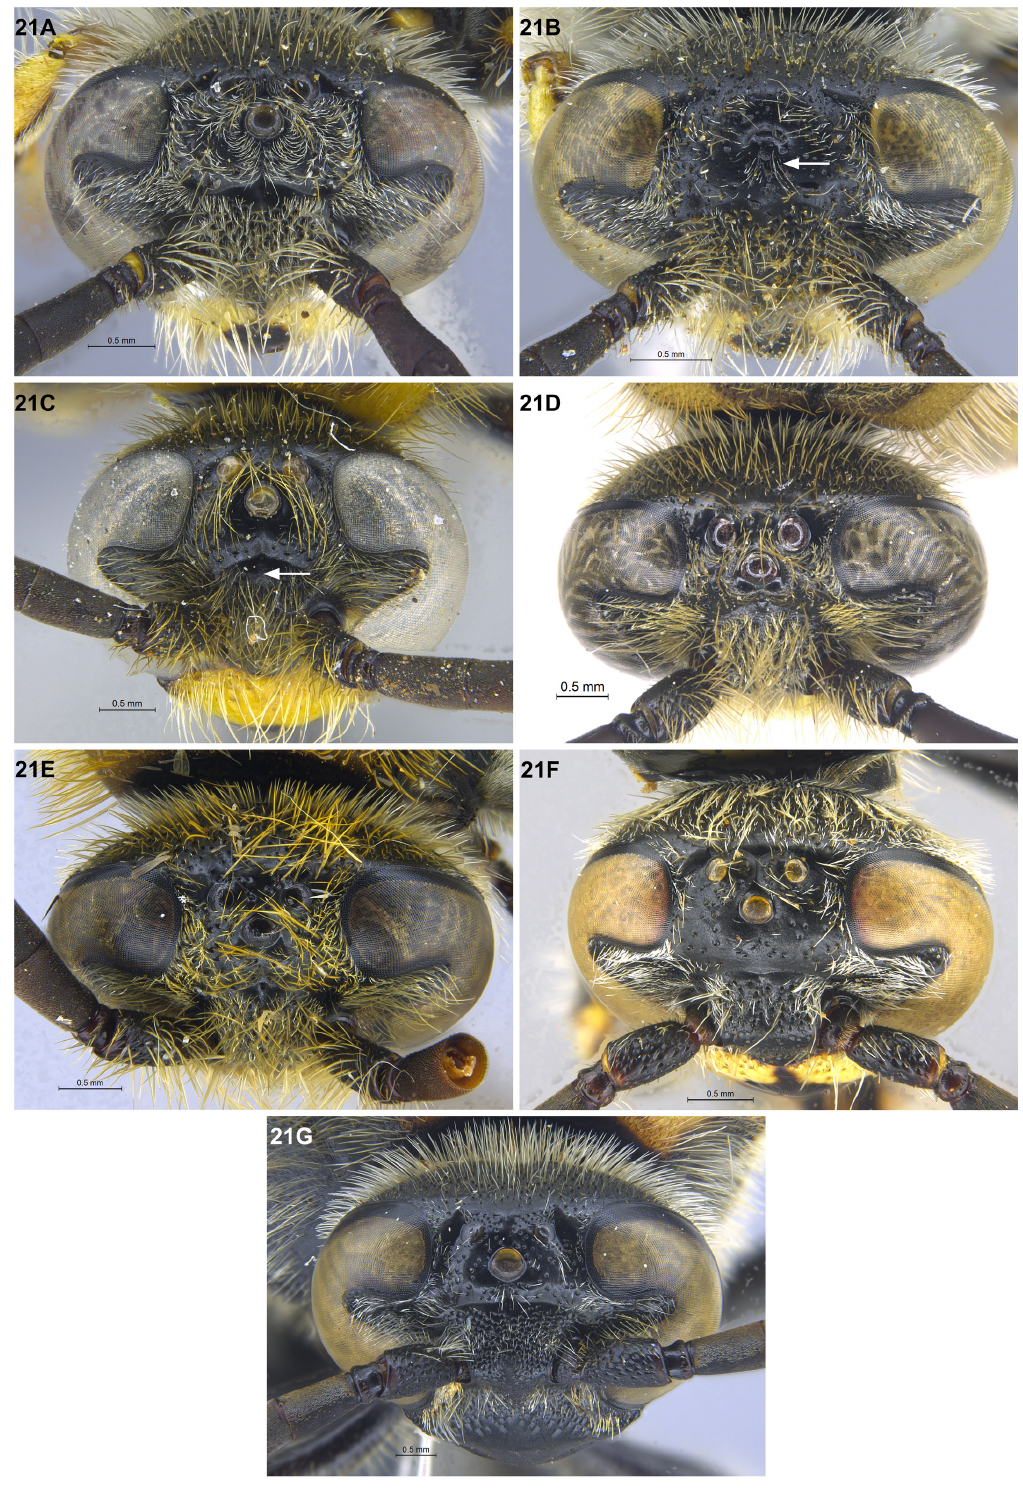
Fig. 21. Males, vertex. A . Campsomeriella annulata annulata (Fabricius, 1793). B . Camps. collaris (Fabricius, 1775). C . Megacampsomeris sp. 1. D . Megacam. formosensis chinensis Betrem, 1941. E . Megacam. prismatica (Smith, 1855). F . Phalerimeris phalerata phalerata (de Saussure, 1858). G . Sericocampsomeris flavomaculata Gupta & Jonathan,